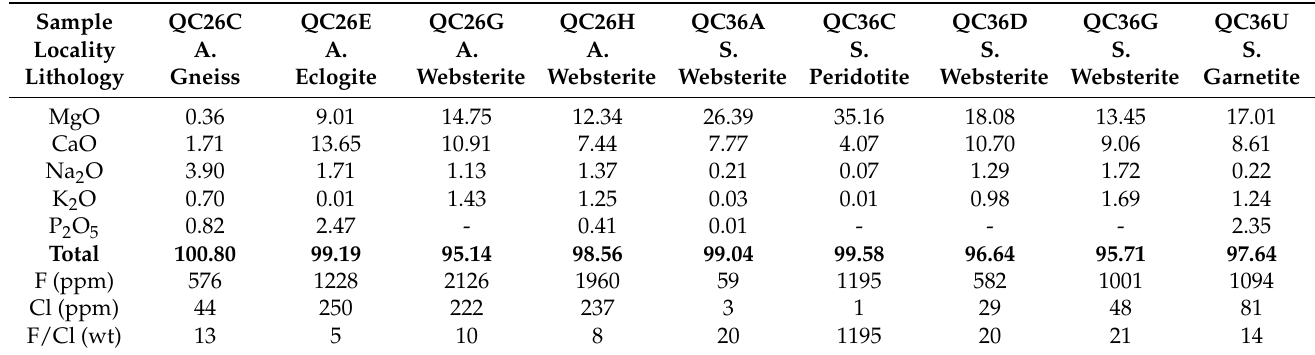
F/Cl ratio of ~0.3, whereas matrix amphibole has an average F/Cl ratio of ~20 (Table 3). Silicon is positively correlated with both F (R 2 = 0.95) and Cl (R 2 = 0.56). Aluminium is negatively correlated with F (R 2 = − 0.76) but shows no correlation with Cl (R 2 = −